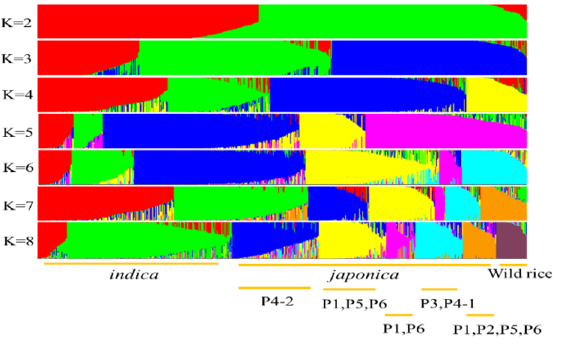
Figure 3. The statistic ∆ K value for each given K in the population structure analysis.